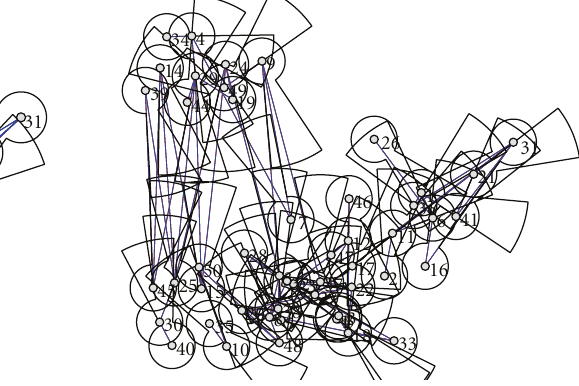
(b) Path probabilty optimization and used capacity mini- mization Figure 5: 50-node example